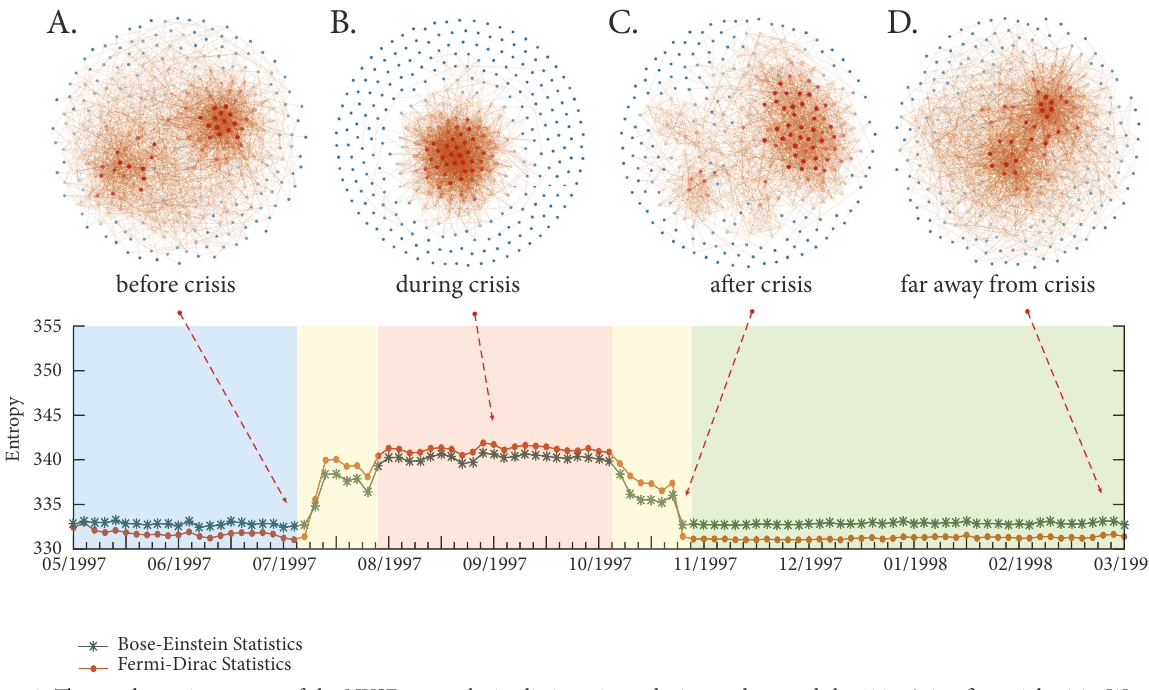
Figure 3: Thermodynamic entropy of the NYSE networks in distinct times during and around the 1997 Asian financial crisis. We show a visualisation of the network at four specific days. Node colours correspond to the degree found for the network. We note that the average degrees of networks A, B, C, and D are the